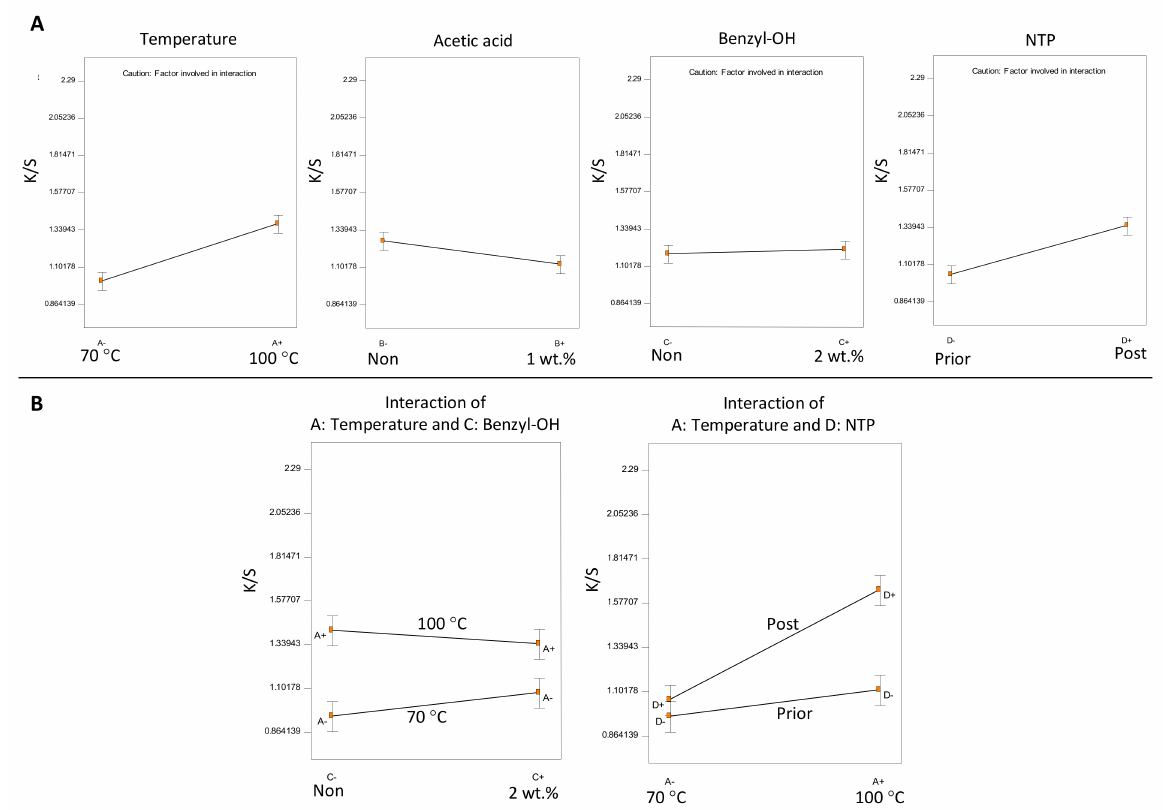
Figure 7. Analysis of Experiment F. ( A ) Main effects of all of the factors and ( B ) the significant